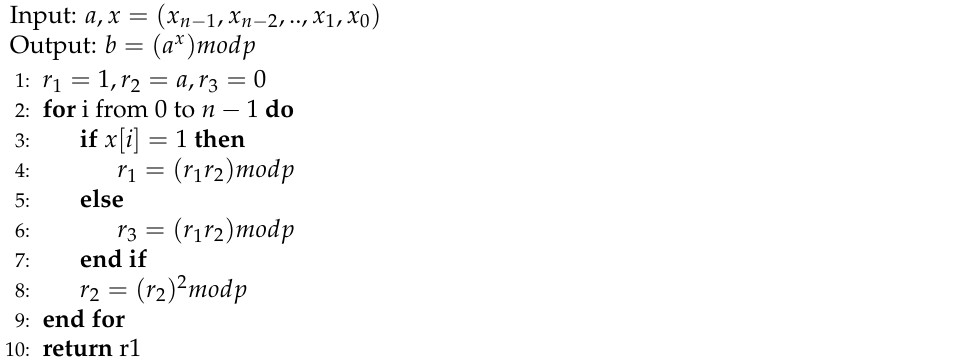
Algorithm 9 Right-to-left Square-and-Multiply for Modular Exponentation.